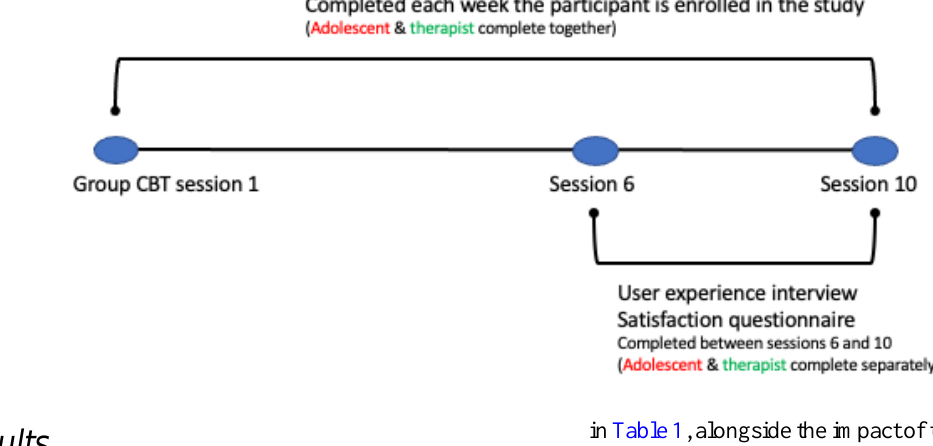
Figure 4. Phase 3 data collection timeline. CBT: cognitive behavioral